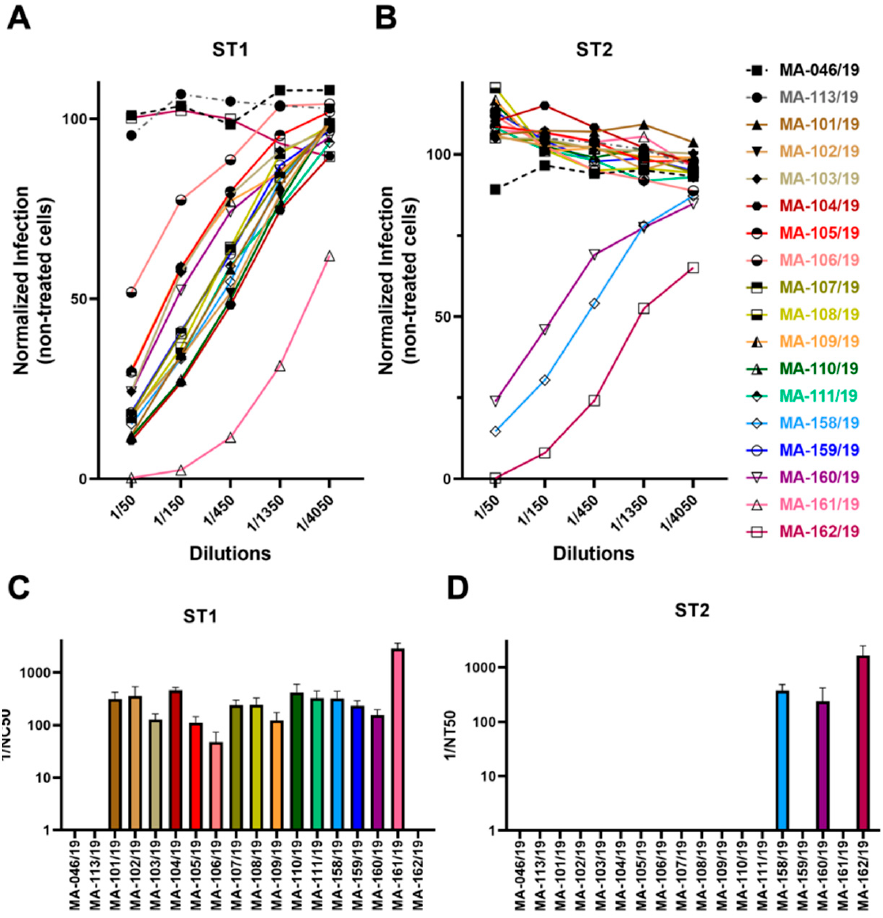
Figure 4. Low frequency of cross neutralization by sera from different animals. Neutralizing activity of rhesus macaque sera against ST1 ( A ) and ST2 ( B ). Infection was measured using flow cytometry to detect expression of the YFP reporter gene. The data show values normalized to infection without rhesus macaque serum. The experiment was performed twice with congruent results. Inverse neutralizing titers (1/NC50 values) were calculated for the individual rhesus macaque sera against ST1 ( C ) and ST2 ( D ) (nonlinear fit for different NC50, inhibitor vs. normalized response model). Error bars represent the 95% confidence interval.